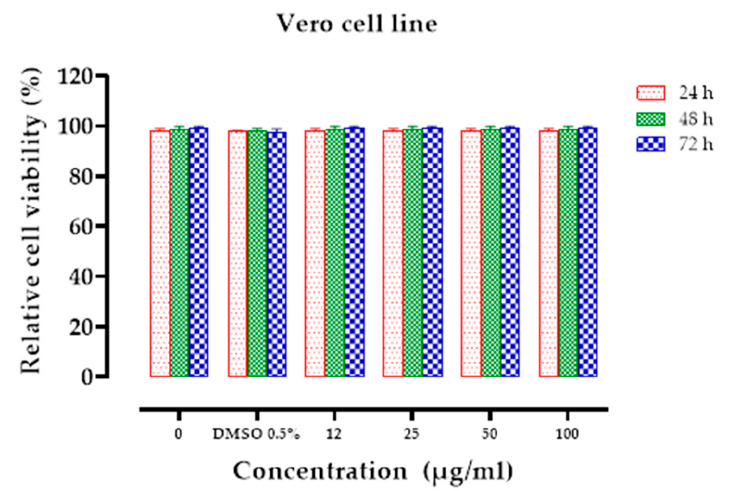
Figure 3. Cytotoxicity of the CSP extract for normal Vero cell line. Relative viability of Vero cells after 24–72 h of treatment with different concentrations of the extract (12–100 µ g/mL). The absorbance values were measured at the wavelength of 570 nm and the mean values ± SD of three experiments, the cell viability was estimated by the MTT assay. The results obtained for the CSP extract suggest a potential synergistic effect between different components when compared with literature data for individual constituents (Ta- ble 1). Table 1. IC 50 of the CSP extract, its components, and the reference molecules towards K562, HL60, and Vero cell lines.